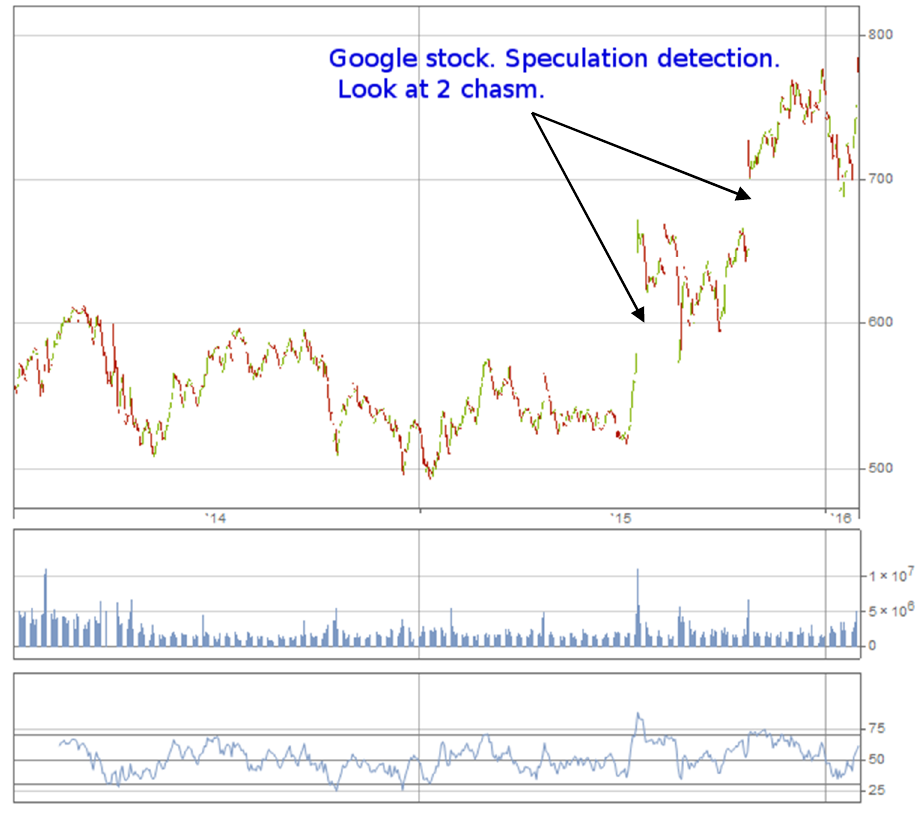
Figure 9. Heston model with analytics for speculation detection for Google stock.